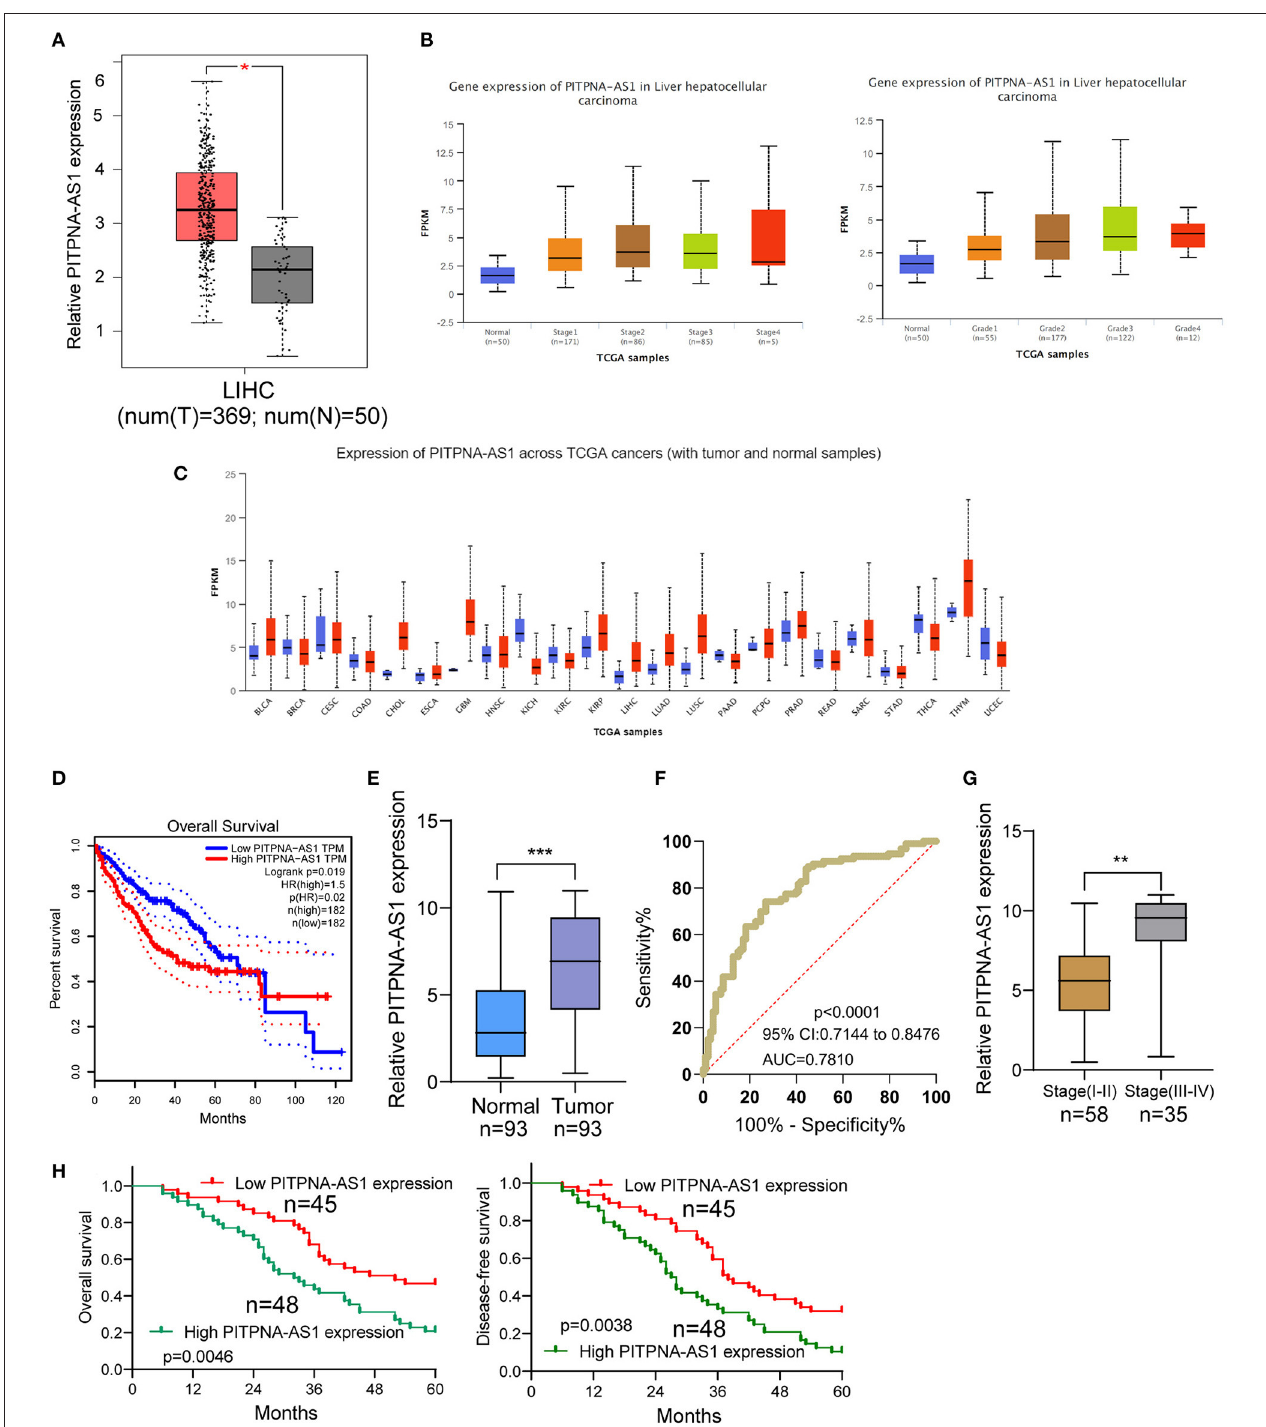
FIGURE 1 | PITPNA-AS1 is upregulated in HCC tissues and is associated with poor prognosis. (A) The distinct upregulation of PITPNA-AS1 expression in HCC specimens ( n = 369) compared to non-tumor specimens ( n = 50) from TCGA datasets. (B) The expressing pattern of PITPNA-AS1 in HCC specimens with different stages. (C) Based on TCGA datasets, Pan-cancer expressions of PITPNA-AS1 were shown. The red column represented the tumor samples and the blue column represented the normal samples. (D) Kaplan-Meier curves for survival time in HCC patients divided according to PITPNA-AS1 expression based on TCGA datasets. (E) RT-PCR for the determination of PITPNA-AS1 expression in 93 pairs of HCC specimens and non-tumor tissues. (F) ROC curves analysis for the HCC diagnostic capability of PITPNA-AS1 expression. (G) Higher levels of PITPNA-AS1 were observed in HCC specimens with advanced stages than those with early stages. (H) Kaplan-Meier curves for overall survival and disease-free survival in patients with HCC divided according to PITPNA-AS1 expression. *** P < 0.001, ** P < 0.01.